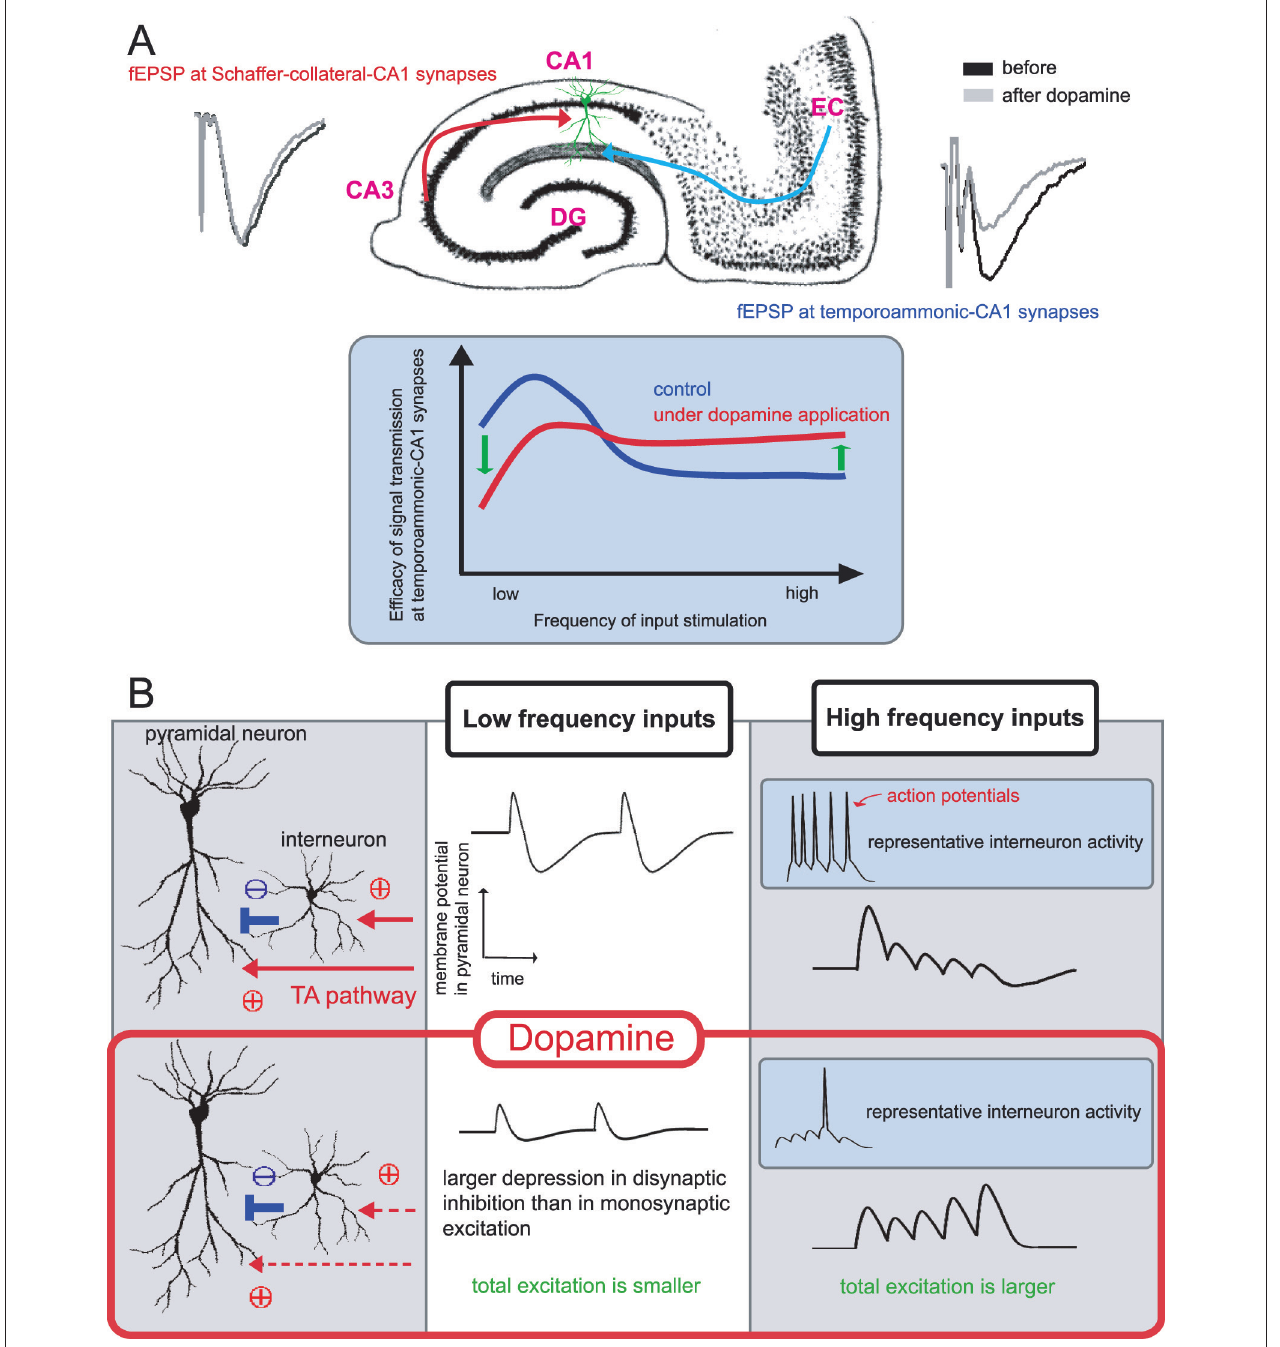
Figure 2 | Frequency dependent modulation of dopamine at temporoammonic-CA1 synapses. (A) Area CA1 in the hippocampus receives two distinct excitatory inputs, one is from area CA3 (the Schaffer-collateral pathway) and another is from the entorhinal cortex (the